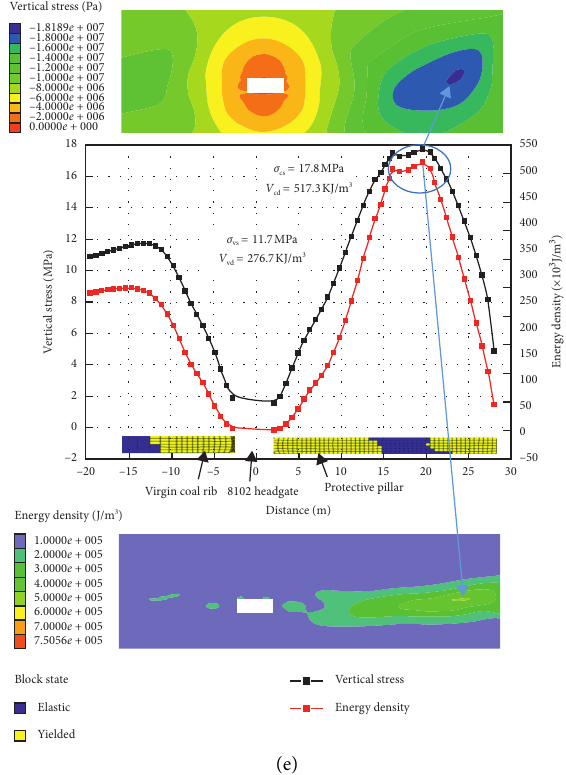
Figure 17: Vertical stress and energy density distribution on two ribs of 8102 headgate with different pillar widths. (a) The width of 5 m. (b) The width of 10 m. (c) The width of 15 m. (d) The width of 20 m. (e) The width of 25 m.